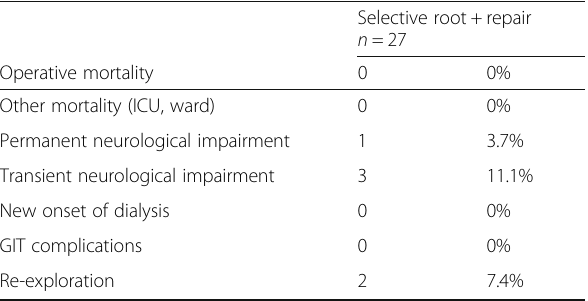
Table 4 Postoperative in-hospital outcomes